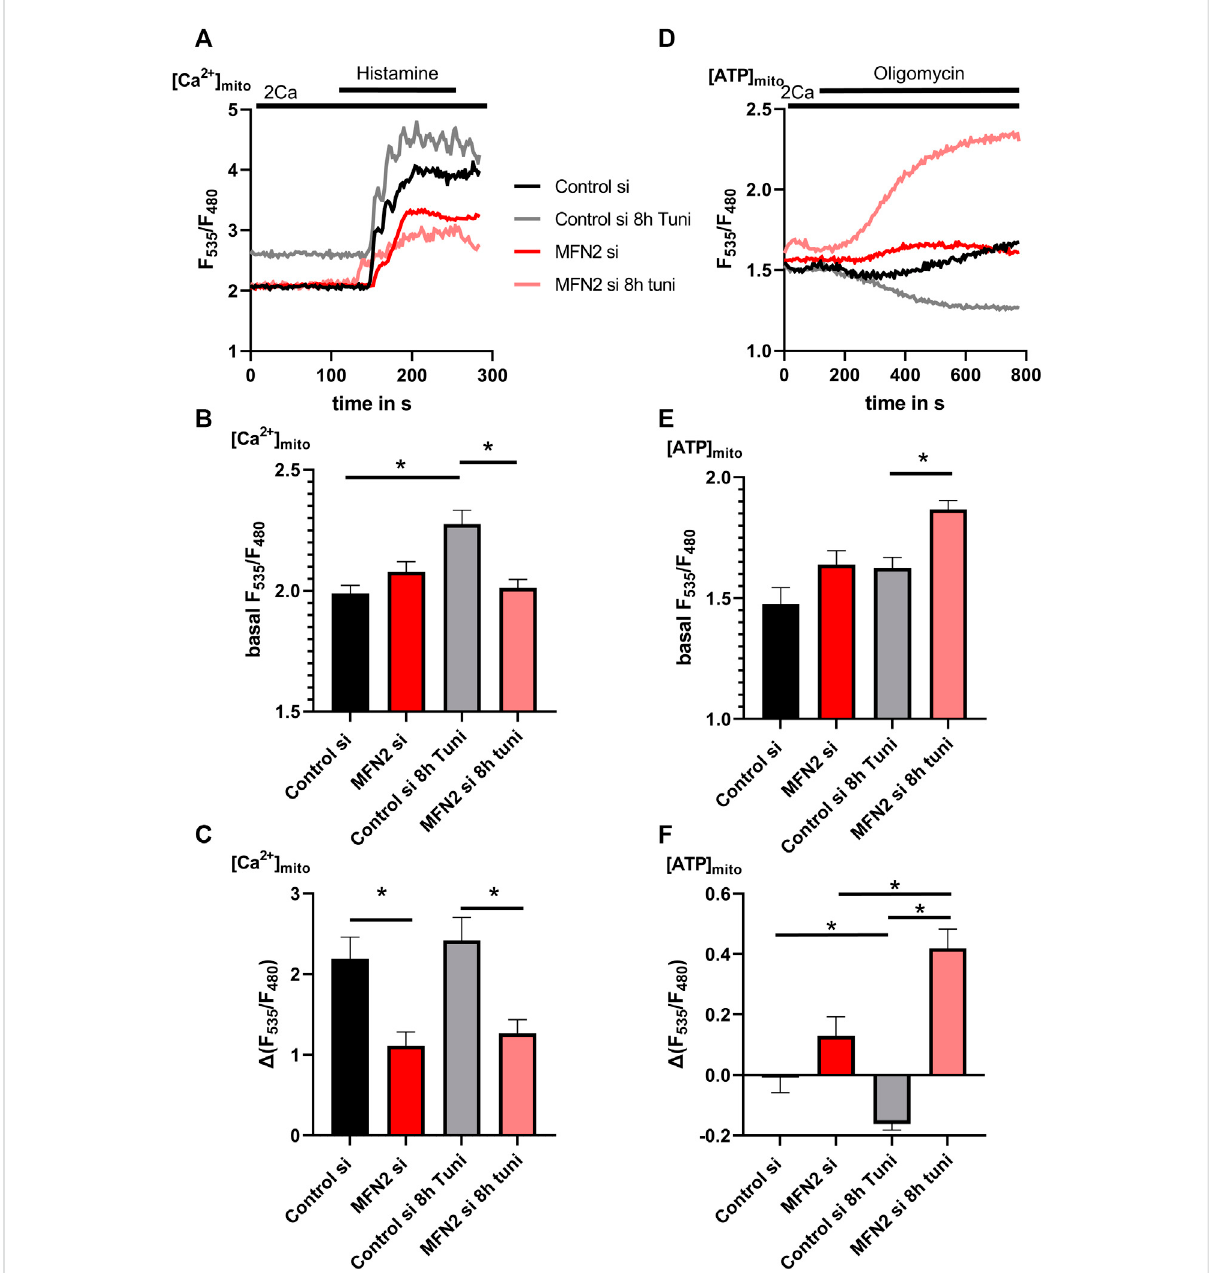
[Ca 2+ ] mito and [ATP] mito of MFN2 silenced HeLa cells show no response on ER-stress. (A) HeLa cells stabile expressing the mitochondrial targeted genetically encoded Ca 2+ sensor 4mtd3cpv were transfected with siRNA against MFN2 or Control siRNA. Representative [Ca 2+ ] mito traces upon histamine induced [Ca 2+ ] ER release of control HeLa cells or HeLa cells treated with 0.6 µM tunicamycin for 8 h. (B) Bar graphs (MEAN ± SEM) represent basal [Ca 2+ ] mito levels of control HeLa cells or HeLa cells treated with tunicamycin for 8 h. (C) Bar graphs (MEAN ± SEM) represent [Ca 2+ ] mito uptake in response to histamine treatment of control HeLa cells or HeLa cells treated with tunicamycin for 8 h (n control si/DMSO = 3/9/48; n control si/8h Tuni = 3/9/35; n MFN2 si/DMSO = 3/9/52; n MFN2 si/8h Tuni = 3/9/55) (D) HeLa cells stabile expressing the mitochondrial targeted genetically encoded ATP sensor mtAT1.03 were transfected with siRNA against MFN2 or Control siRNA. Representative [ATP] mito traces upon oligomycin addition of control HeLacells or HeLa cells treated with Tunicamycin for 8 h. (E) Bar graphs (MEAN ± SEM) represent basal [ATP] mito levels of control HeLacells orHeLacells treatedwith tunicamycin for8 h. (F) Bargraphs (MEAN ± SEM)represent [ATP] mito uponoligomycinaddition ofcontrol HeLa cells or HeLa cells treated with tunicamycin for 8 h (n control si/DMSO = 3/9/89; n control si/8h Tuni = 3/9/80; n MFN2 si/DMSO = 3/9/66; n MFN2 si/8h Tuni = 3/9/ 82). * p < 0.05 vs. respective control conditions carried out with one-way ANOVA with Tukey corrected posthoc